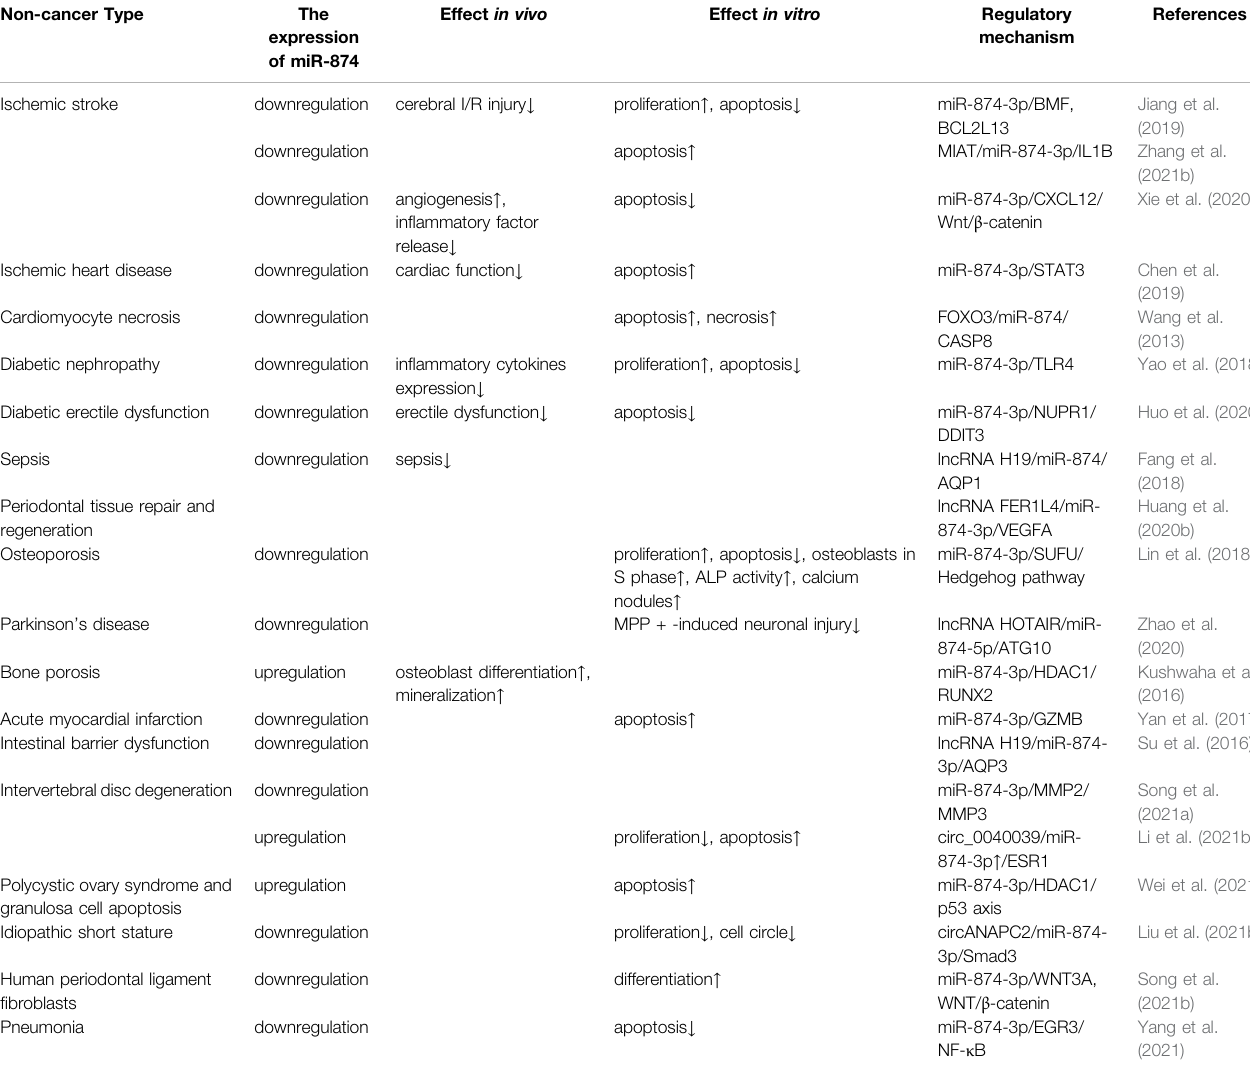
TABLE 2 | The role of miR-874 in human non-cancer